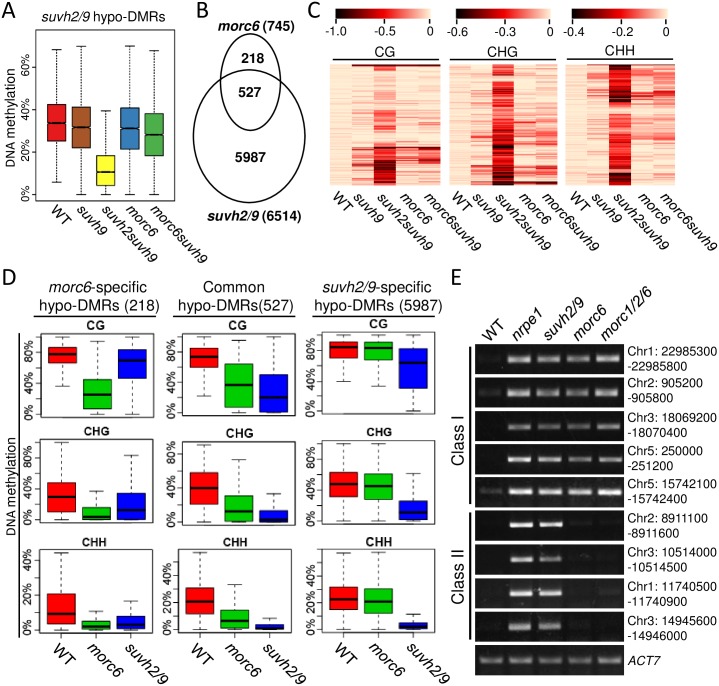
The involvement of MORC6 in DNA methylation at a small subset of RdDM target loci.(A) Box plots showing DNA methylation levels of suvh2/9 hypo-DMRs in the indicated mutants. (B) Venn diagram of overlap between hypo-DMRs in morc6 and suvh2/9. (C) Heat maps showing DNA methylation changes within suvh2/9 hypo-DMRs in the wild type and the mutants. Different scales were used for CG, CHG, and CHH methylation. In the scales, the DNA methylation levels of the wild type were set as 0 (light yellow lines) and absolute DNA methylation changes were represented by lines whose colors are ranged from light yellow to black. (D) DNA methylation levels of morc6-specific hypo-DMRs, suvh2/9-specific hypo-DMRs, and hypo-DMRs shared by morc6 and suvh2/9 are indicated at three cytosine contexts in the wild type, morc6, and suvh2/9. (E) Validation of bisulfite sequencing results by PCR-based DNA methylation analysis. Genomic DNA was cleaved by McrBC, a restriction enzyme that specifically recognizes methylated DNA. Class I represents hypo-DMRs shared by morc6 and suvh2/9; Class II represents suvh2/9-specific hypo-DMRs. The RdDM pathway contributes to CHH methylation and to a lesser extent to CG and CHG methylation [5], but it is unknown how MORC6 contributes to DNA methylation at the three cytosine contexts. Our analysis indicated that morc6 affects DNA methylation at all the three cytosine contexts (CG, CHG, and CHH) in a small subset of the 6514 suvh2/9 hypo-DMRs (Fig 1C). In the 527 hypo-DMRs shared in morc6 and suvh2/9, DNA methylation is reduced at all three cytosine contexts in both morc6 and suvh2/9 (Fig 1D). In the 218 morc6 specific hypo-DMRs, DNA methylation is reduced at all three cytosine contexts in the morc6 mutant (Fig 1D). Although the 218 morc6 specific hypo-DMRs do not overlap with the suvh2/9 hypo-DMRs, the DNA methylation level of the 218 hypo-DMRs is reduced at CHG and CHH sites in suvh2/9 (Fig 1D). However, CG methylation of the 218 hypo-DMRs is markedly reduced in morc6 but not in suvh2/9 (Fig 1D). Thus, these 218 hypo-DMRs could be either RdDM-independent loci or RdDM-dependent loci that are not dependent on SUVH2/9.